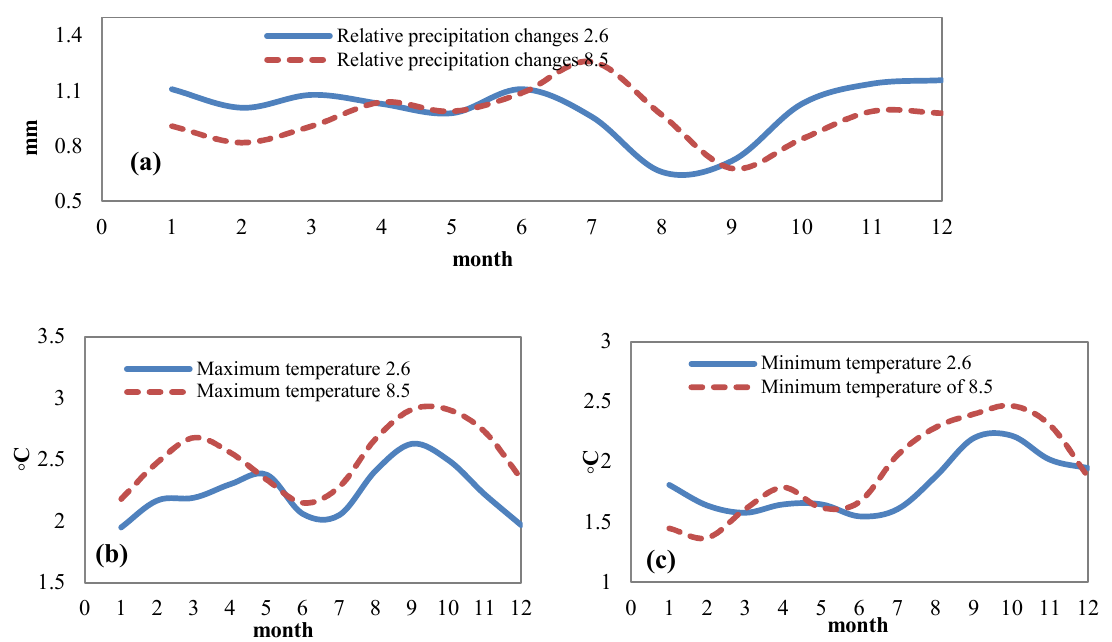
Figure 1. Comparison of the relative changes in ( a ) precipitation, ( b ) maximum and ( c ) minimum temperature under the RCP8.5 & RCP2.6 scenarios within the base period.